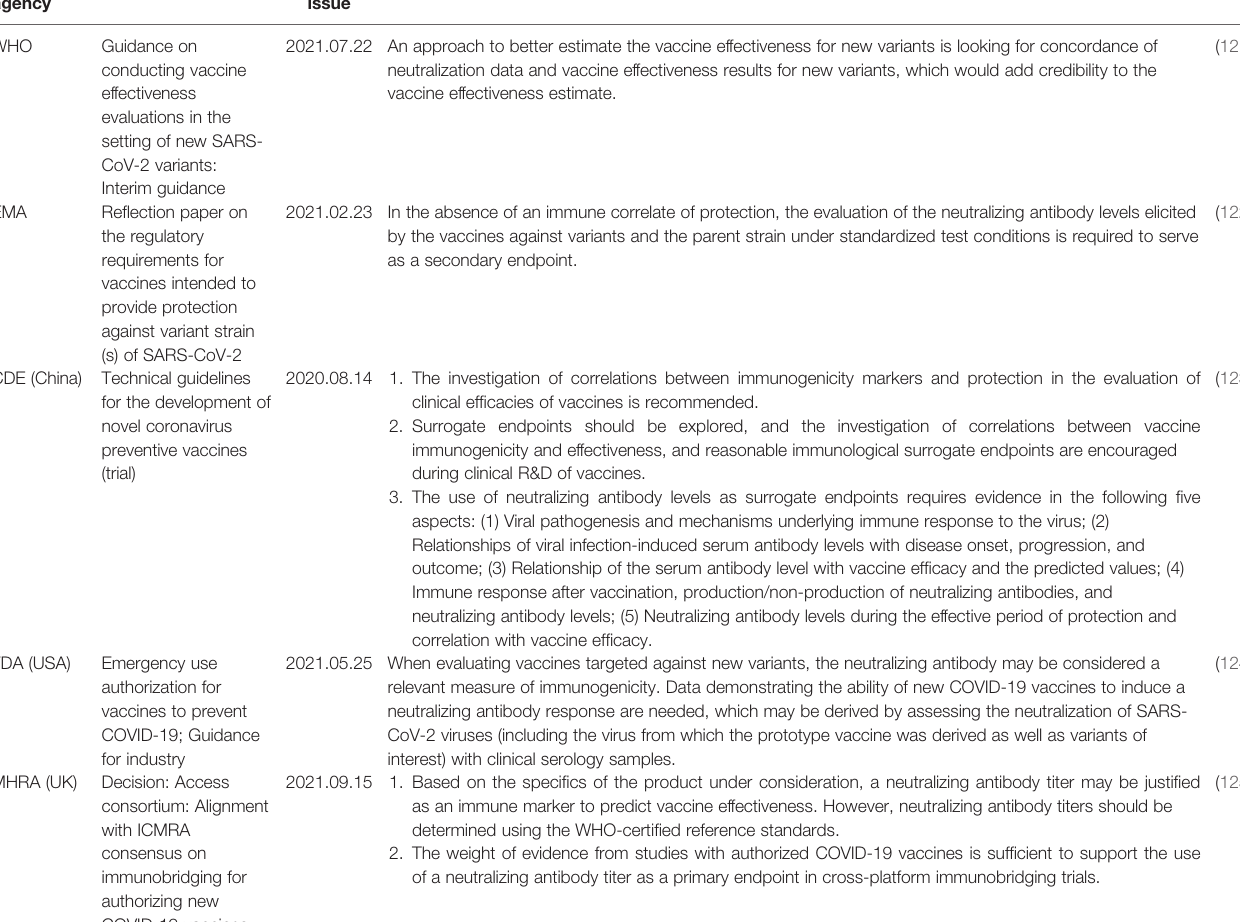
TABLE 6 | Guidance for COVID-19 vaccine